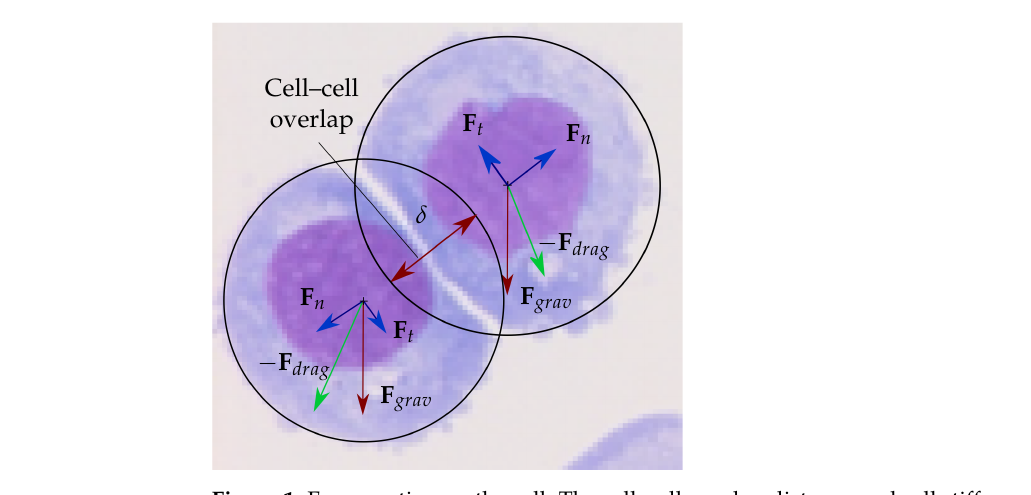
Figure 1. Forces acting on the cell. The cell–cell overlap distance and cell stiffness were considered when computing contact forces. Drag forces were determined using the momentum exchange between the cell and the fluidic